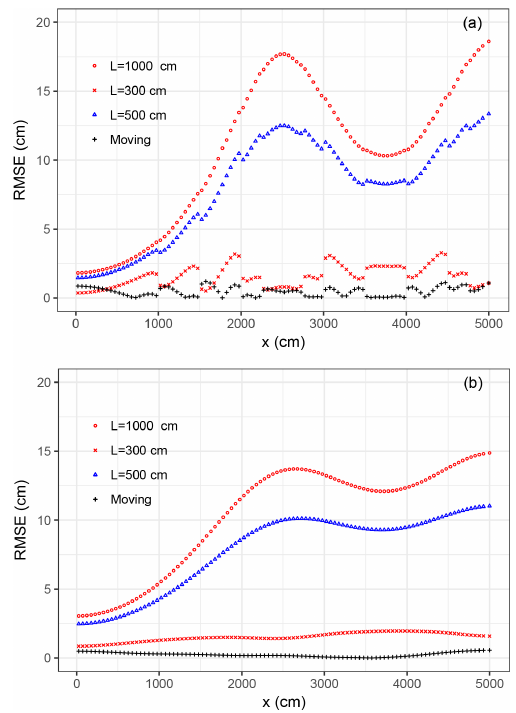
Figure 10. Comparison of RMSE of (a) the phreatic surface and (b) the head solution (at z = 0) between the moving-boundary and the stationary-boundary methods. Three different lengths of the sta- tionary soil columns, L = 1000, 500, and 300cm, are considered.